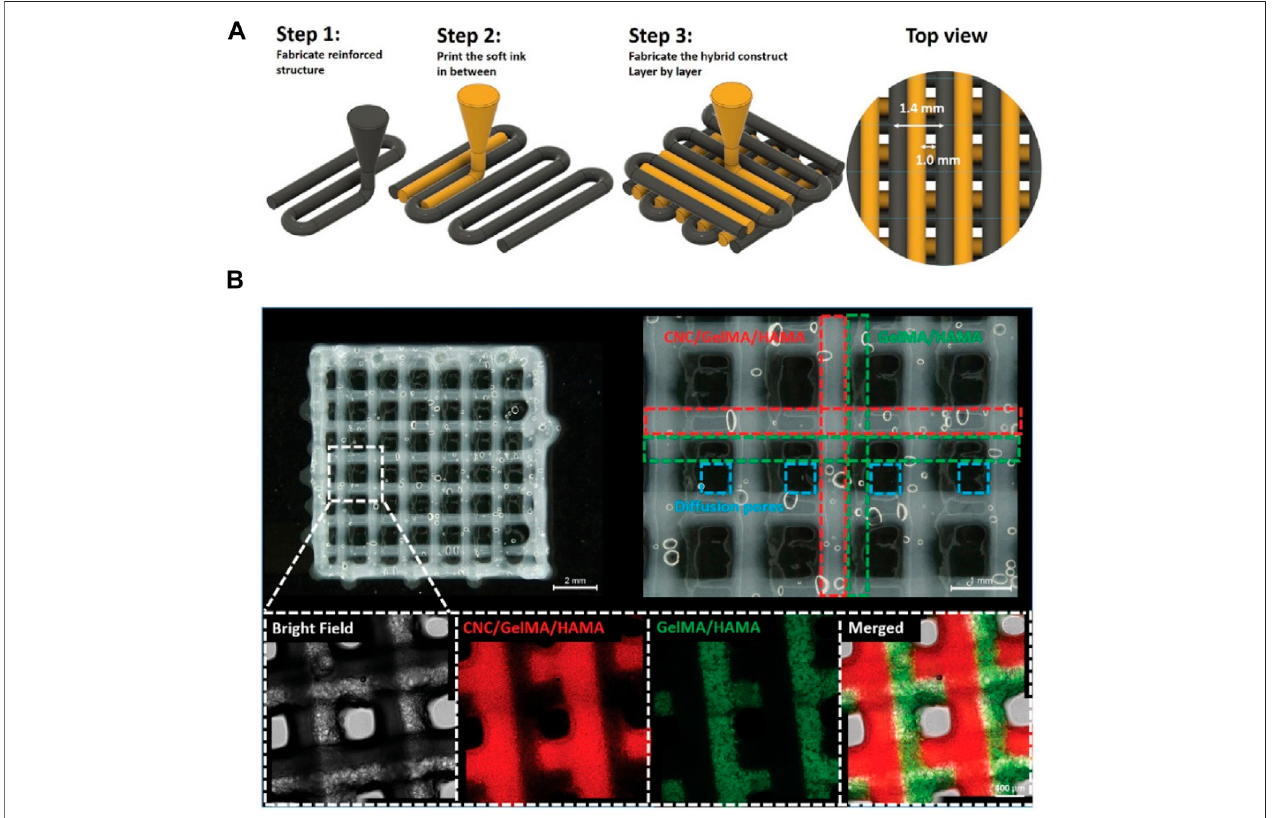
FIGURE4|(A) Illustrationofthehybridprintingprocedure. (B) Opticalandconfocalmicroscopicobservationofthehybridprintedconstruct.Theresultingholesare de fi ned by blue dashed lines. The fl uorescence in confocal images is from fl uorescence-labeled GelMA (red: rhodamine-labeled GelMA; Green: FITC-marked GelMA) in CNC-enhanced inks or GelMA/HAMA inks. Reproduced from Fan et al., (2020b) with permission from Copyright 2020 Wiley.